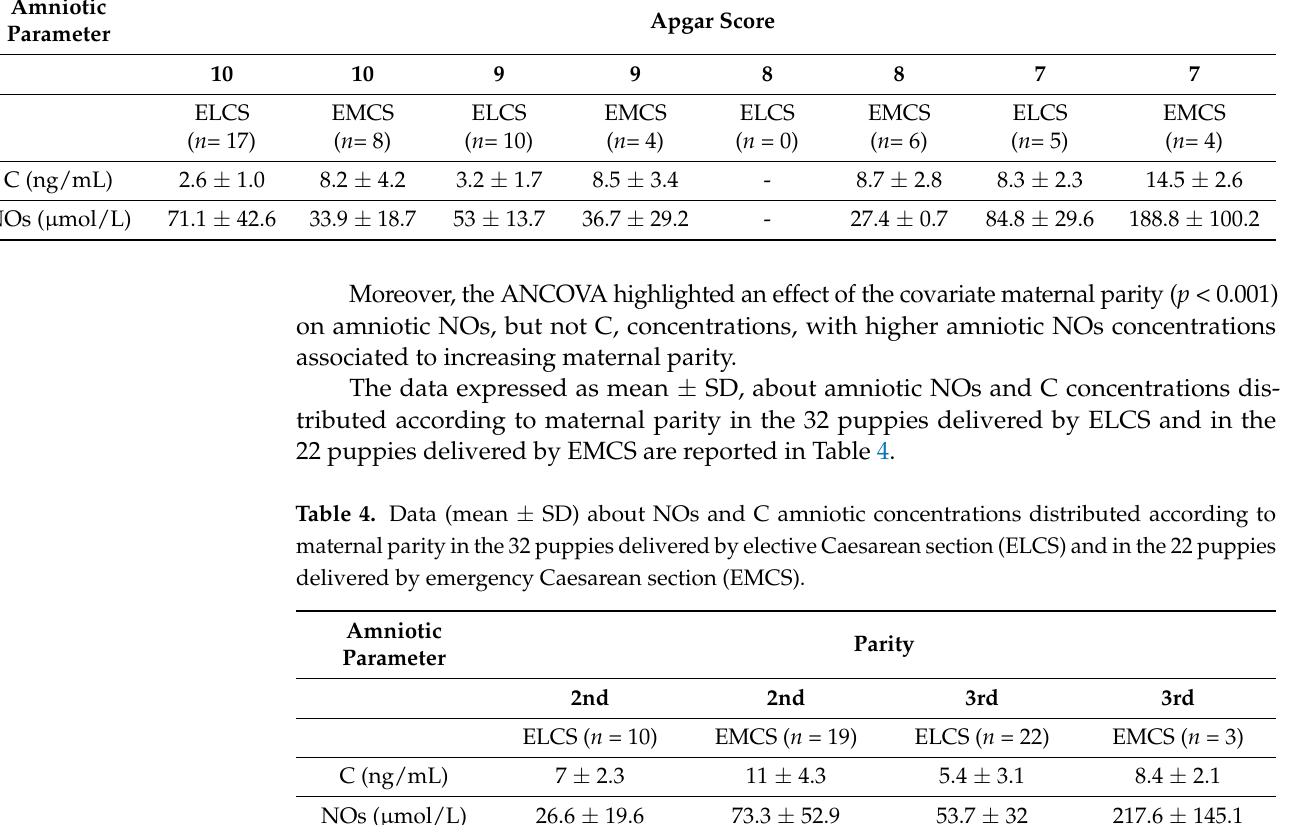
Table 3. Data (mean ± SD) about NOs and C amniotic concentrations distributed according to Apgar score in the 32 puppies delivered by elective Caesarean section (ELCS) and in the 22 puppies delivered by emergency Caesarean section (EMCS). Amniotic Parameter